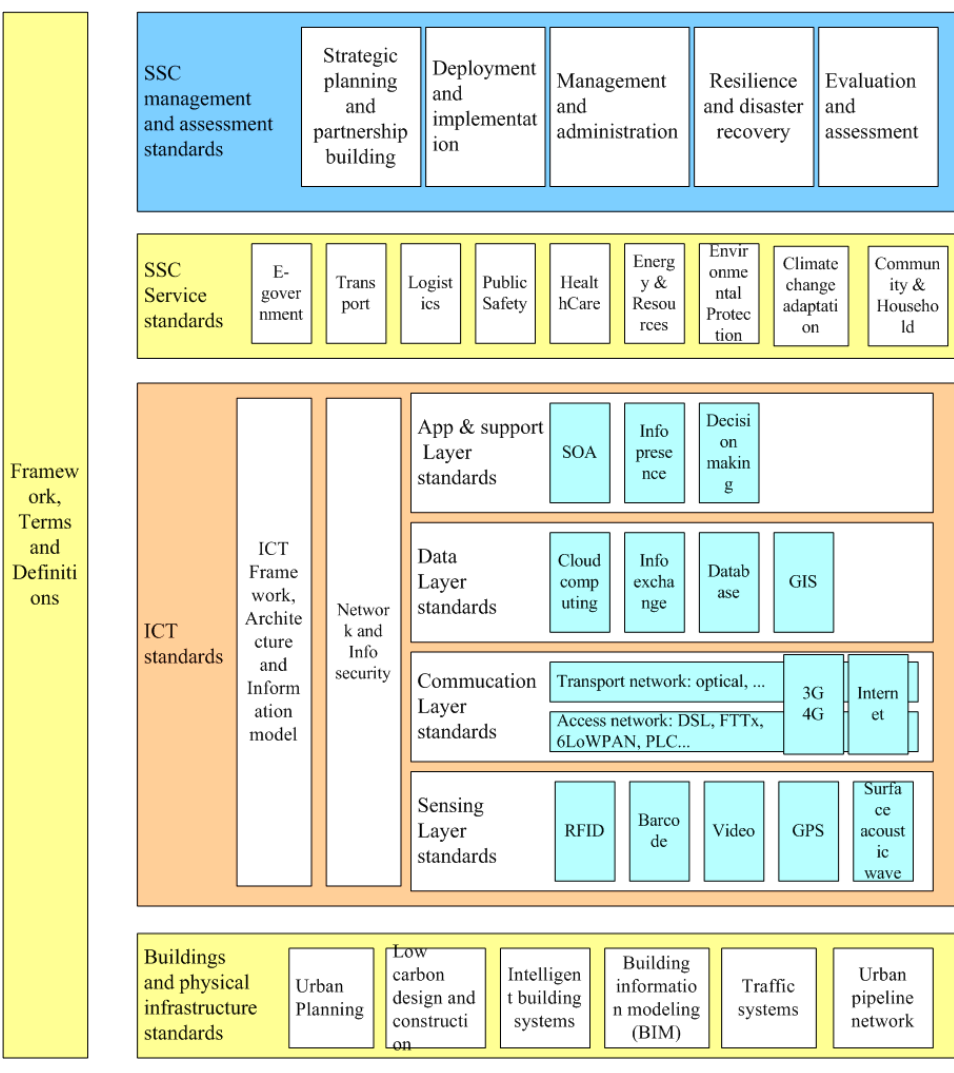
Figure 1. Framework of SSC standards.